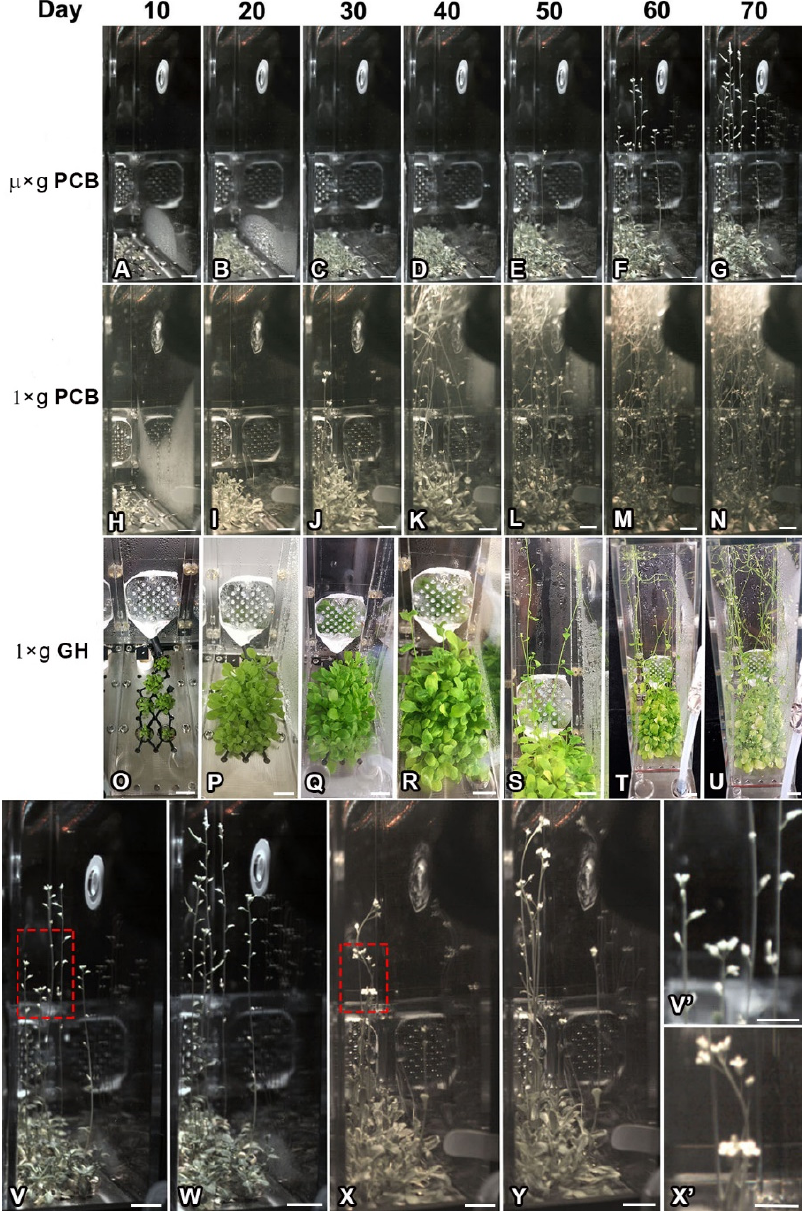
Figure 2. Response of Arabidopsis plants growth under the long-day (LD) condition under microgravity in space in comparison with that of the controls on ground. ( A – U ) Example images of plants were recorded at days 10, 20, 30, 40, 50, 60, and 70 after sowing in plant culture box (PCB) in space ( A – G ) and on ground either in PCB ( H – N ) or in greenhouse (GH) ( O – U ), respectively. ( V – Y ) Magnified views of the plants in PCB at day 60 and day 70 in space ( V , W ) and on day 31 and day 32 on ground ( X , Y ). ( V’ , X’ ) Enlarged images of the red framed area in V and X, respectively. Note that flowers could not fully open in space ( V’ ) in comparison with that of the ground controls ( X’ ). µ× g -PCB, in PCB under microgravity in space. 1× g -PCB, in PCB under the normal gravity (1× g ) on